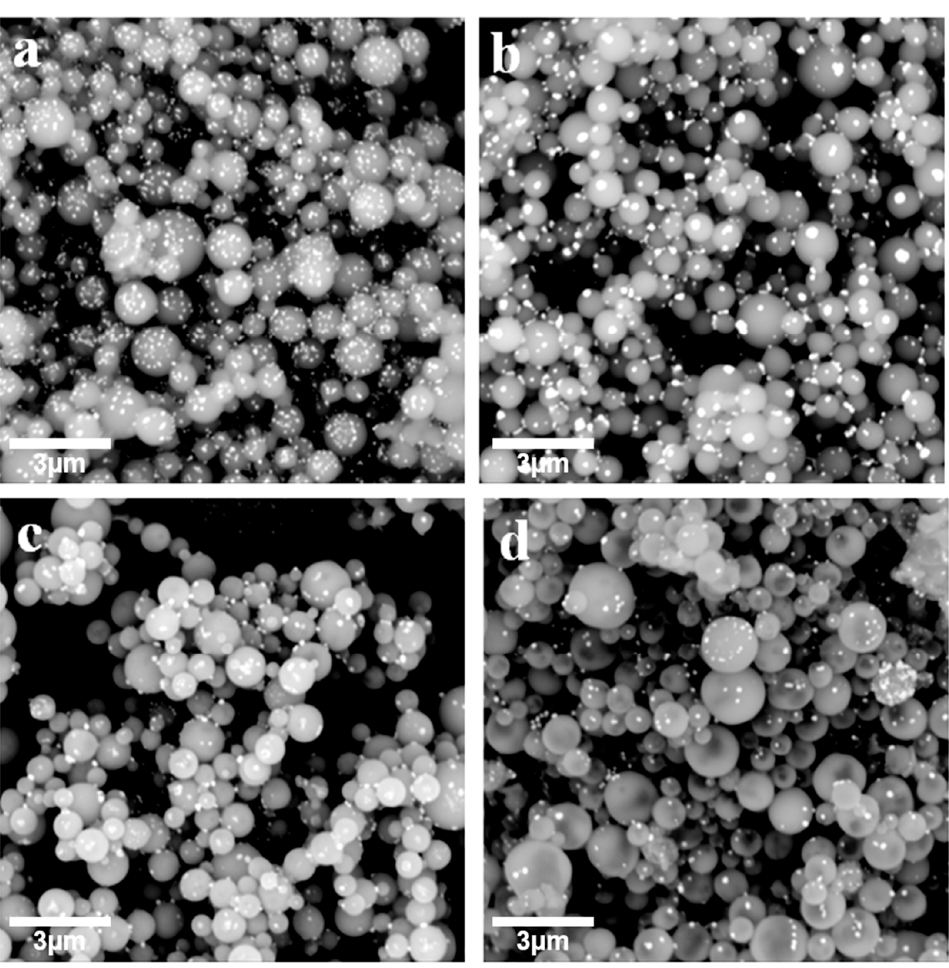
Figure 2. SEM photos of as-synthesized LiFePO 4 precursor powder at spray drying temperature of